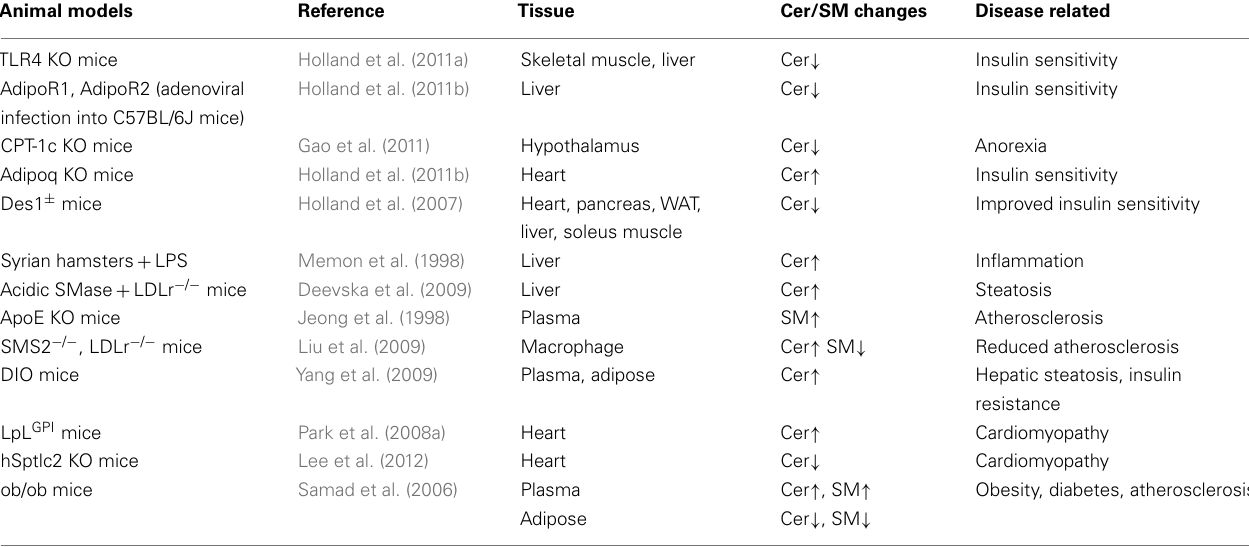
Table 1 |Alteration of tissue ceramide levels and related diseases in animal models of obesity and metabolic syndrome. Animal